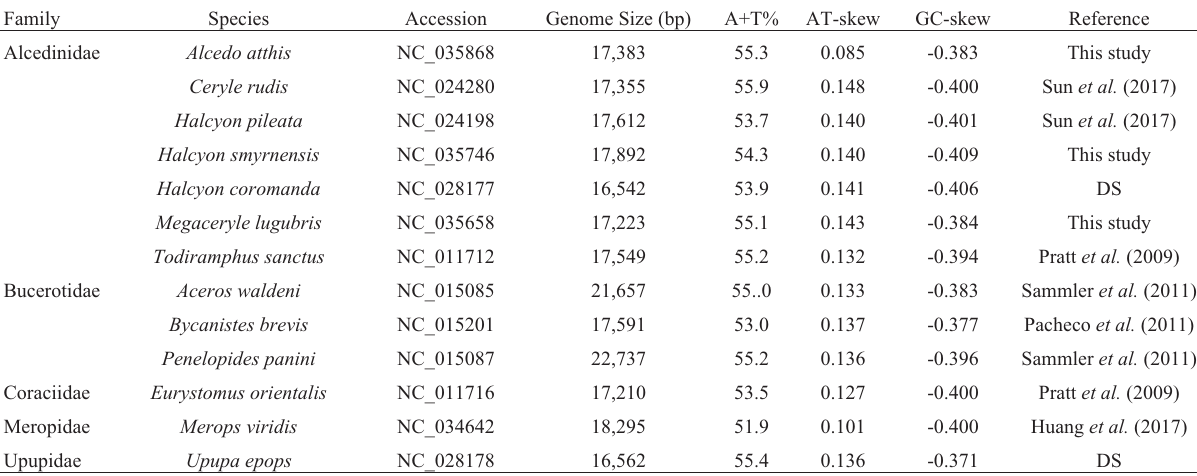
Table 1 - Coraciiform species of mitogenomes analyzed in this